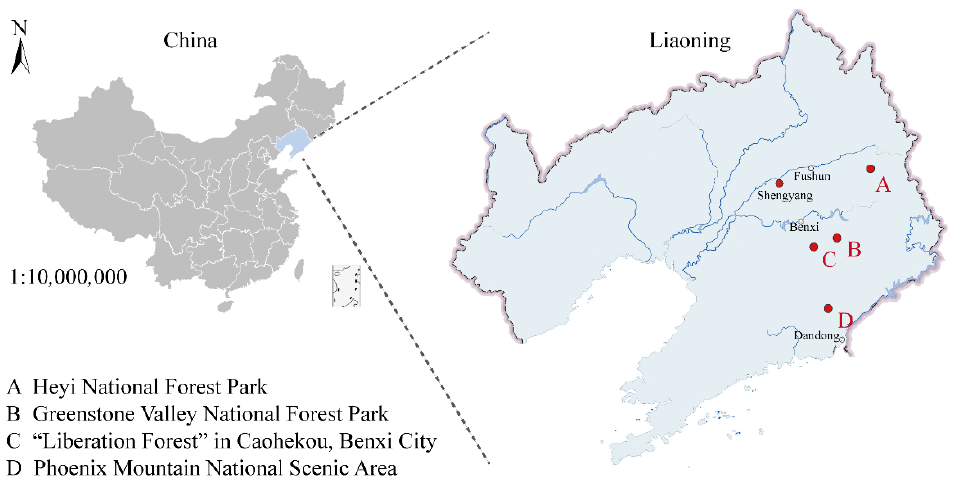
Figure 1. Locations of the study sites. A: Heyi National Forest Park is located in southeastern Fushun City, Liaoning Province, with a total area of 1367.85 hectares. B: Greenstone Valley National Forest Park is part of Tanggou National Forest Park of Benxi, Liaoning, with a total area of 2.167 hectares; C: “Liberation Forest” in Caohekou, Benxi City, is the first artificial Korean pine forest in China; D: Phoenix Mountain National Scenic Area is located in Fengcheng City, Liaoning Province, with a total area of 18,200